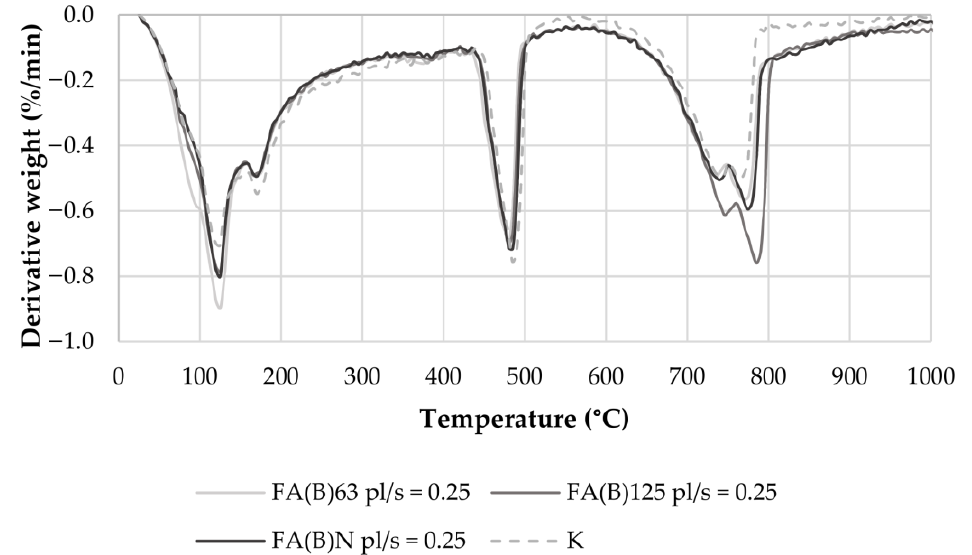
Figure 10. Derivative thermogravimetric (DTG) curves of mortars with a 25% addition of sieved fly ash (FA(B)63 or FA(B)125) compared with the results of mortars with a 25% addition of untreated fly ash (FA(B)N).